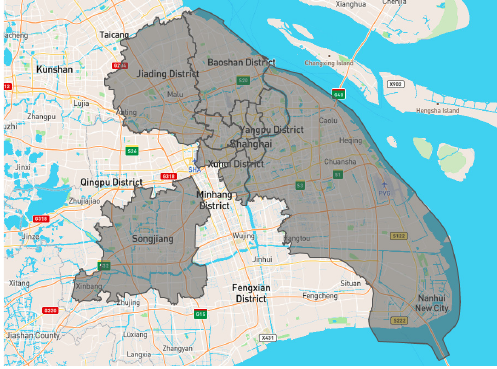
Figure 5. Detection regions of road information.